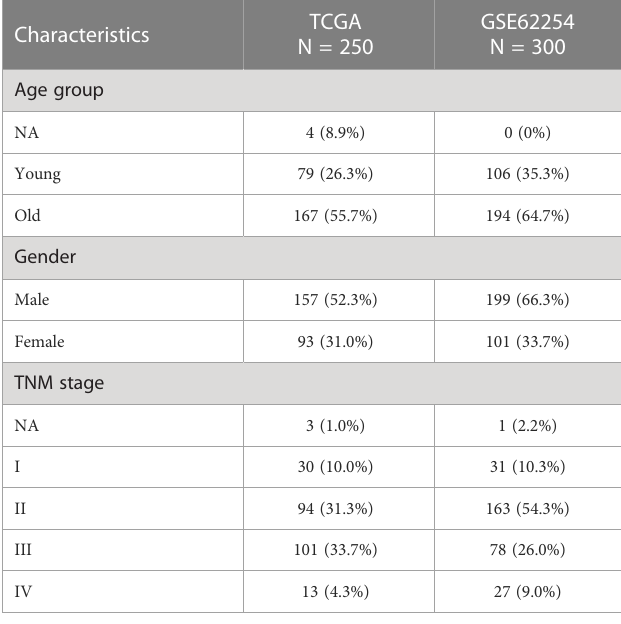
TABLE 1 Baseline clinical characteristics of gastric cancer